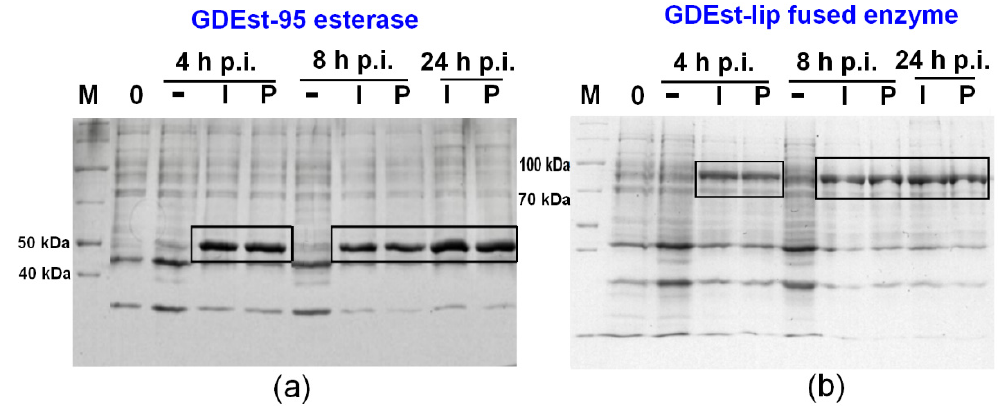
Figure 4. Synthesis of recombinant GDEst-95 esterase ( a ) and GDEst-lip fused enzyme ( b ) in E . coli BL21 (DE3) cells using 4 mM milk permeate (P) as an inducer. Induction in mM9 medium supplemented with 100 μ g/mL ampicillin and 1 mM of IPTG (I) as an inducer were used as control. M—PageRuler™ Unstained Broad Range Protein Ladder; – - control sample of recombinant E . coli BL21 (DE3) cells growing without induction; p.i.—post-induction time (in hours). The target enzymes are marked with black boxes. Glycine-SDS-PAGE was used for analysis.